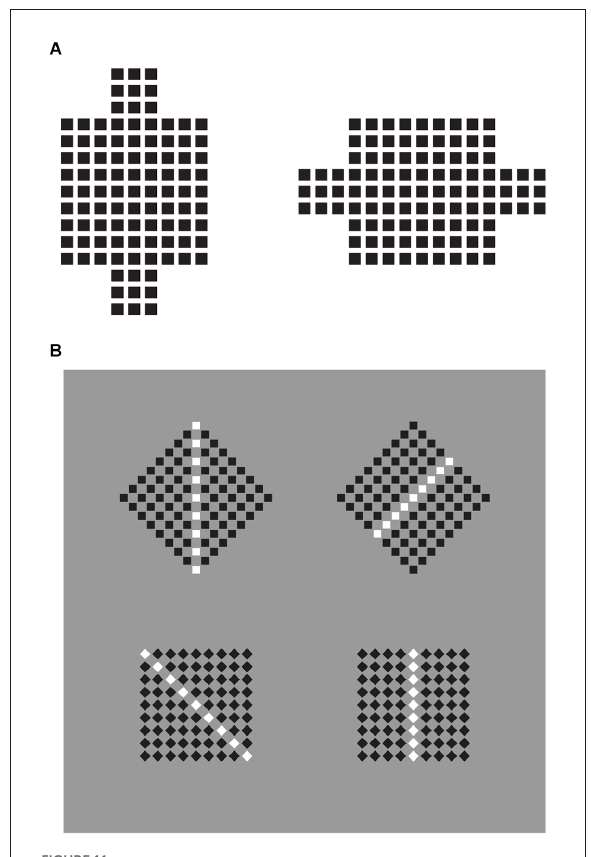
FIGURE11 (A) Slimming (left) and widening (right) effects of the inner whole square made of small squares. (B) Squares perceived as squares and squares perceived as diamonds (first row); diamonds perceived as rotated squares and diamonds perceived as diamonds (second